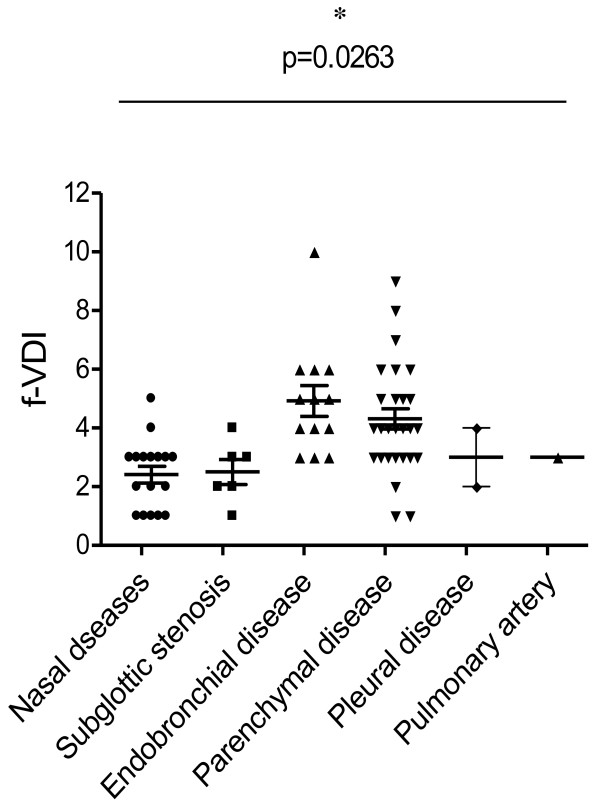
VDI scores at 2-year follow-up (f-VDI) in subjects initially presenting with different pulmonary manifestations (which may overlap). Data are represented as mean ± SEM. A three-way ANOVA test was used to calculate differences between the groups with a significance p-value cut-off of 0.05 (*p < 0.05, **p < 0.01, ***p < 0.001).